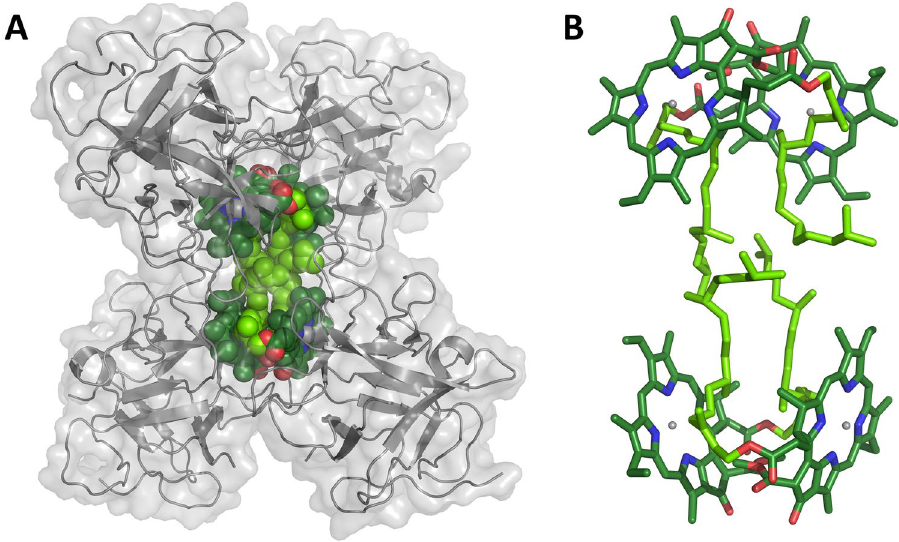
Figure 1. ( A ) Structure of L. virginicum tetrameric WSCP (PDB entry: 2DRE) 11 , with the polypeptide chains shown in gray cartoons, the protein surface in transparent gray, and the Chls a in spheres. The chlorin macrocycle is colored with carbon atoms in dark green, nitrogen atoms in blue, oxygen atoms in red and magnesium atoms in gray. The carbon atoms of the phytyl chains are colored in light green. ( B ) “Open sandwich” structure of Chl dimers shown in